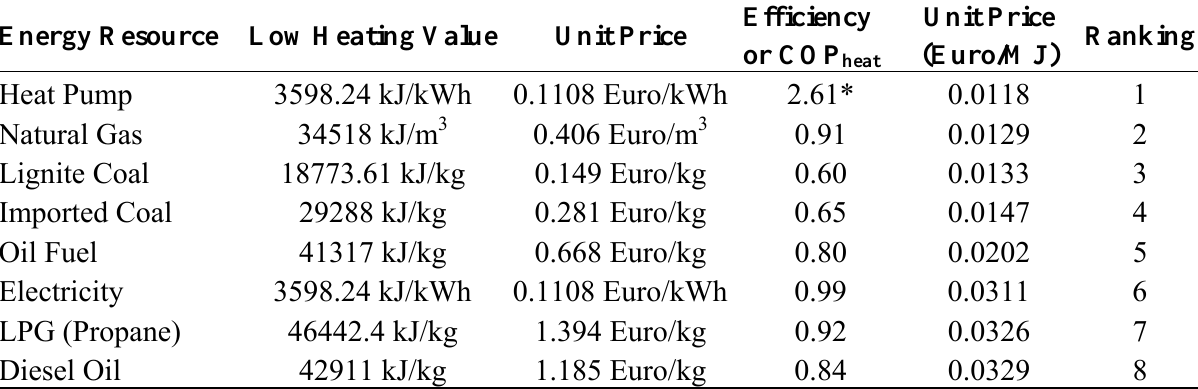
Table 1. Comparison of the energy cost of the heat pump with the other energy resources